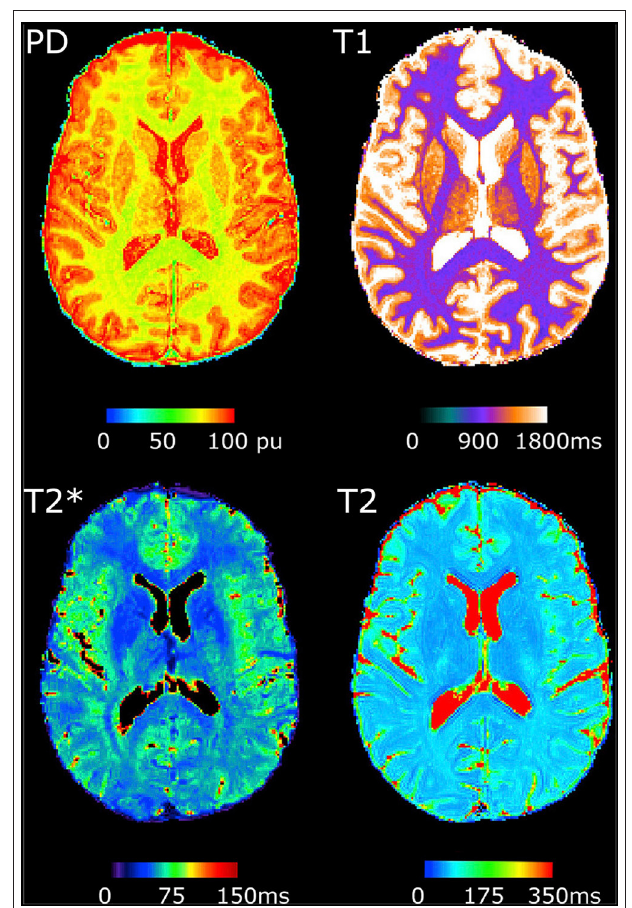
FIGURE 1 | Examples of quantitative MRI maps of a single subject. PD, Proton density. The figure has been published under a Creative Commons license (https://creativecommons.org/licenses/by-nc-nd/4.0/) by Gracien et al. (3).